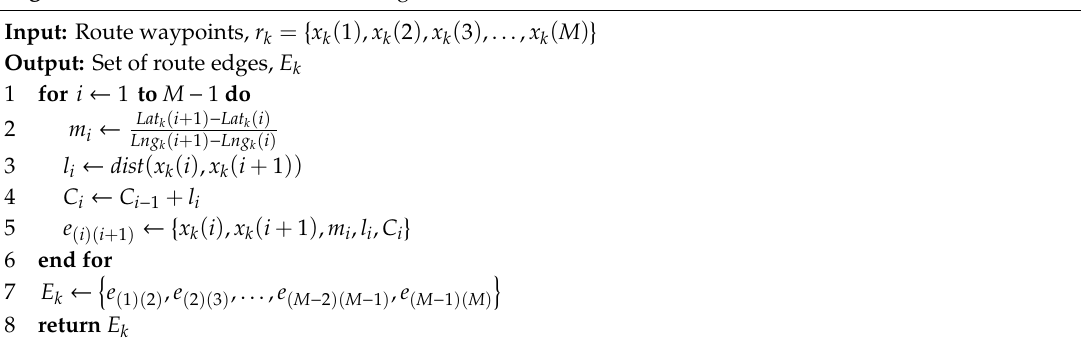
Algorithm 1: To obtain a set of route